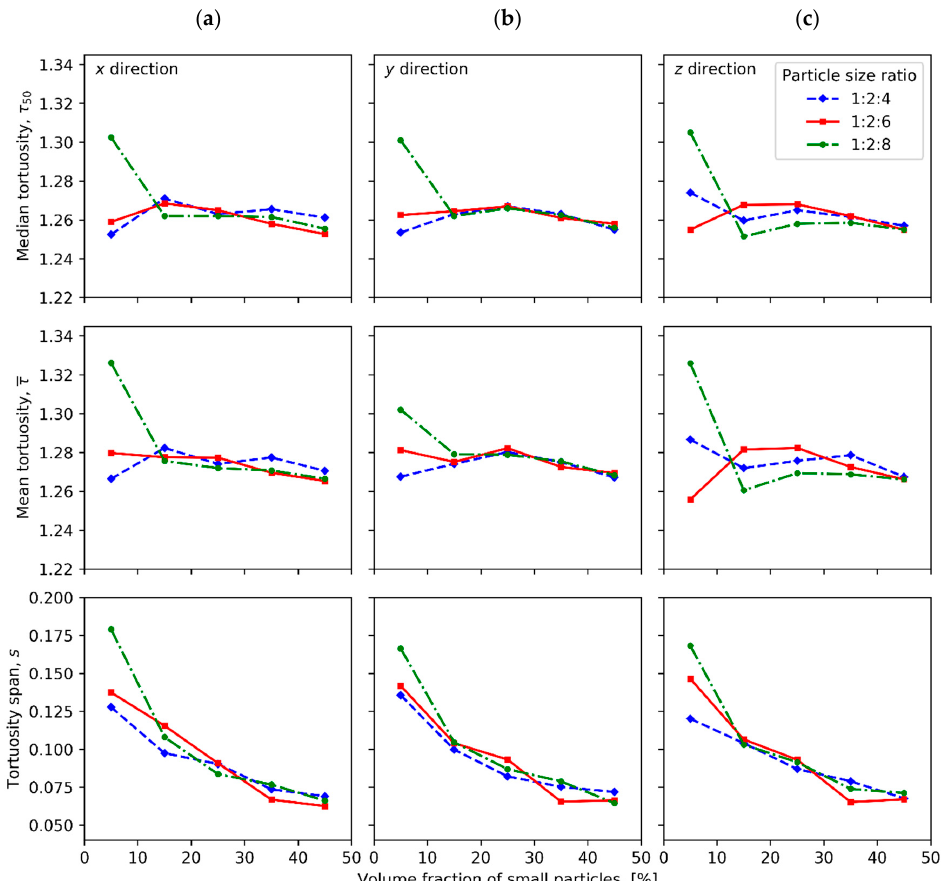
Figure 4. Median, mean and span of tortuosity distribution of compacts of various volume fractions of small particles measured in ( a ) x, ( b ) y and ( c ) z directions.